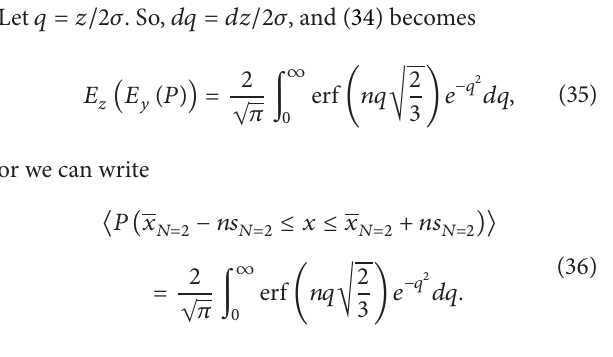
2 𝑑𝑞 versus the esti-